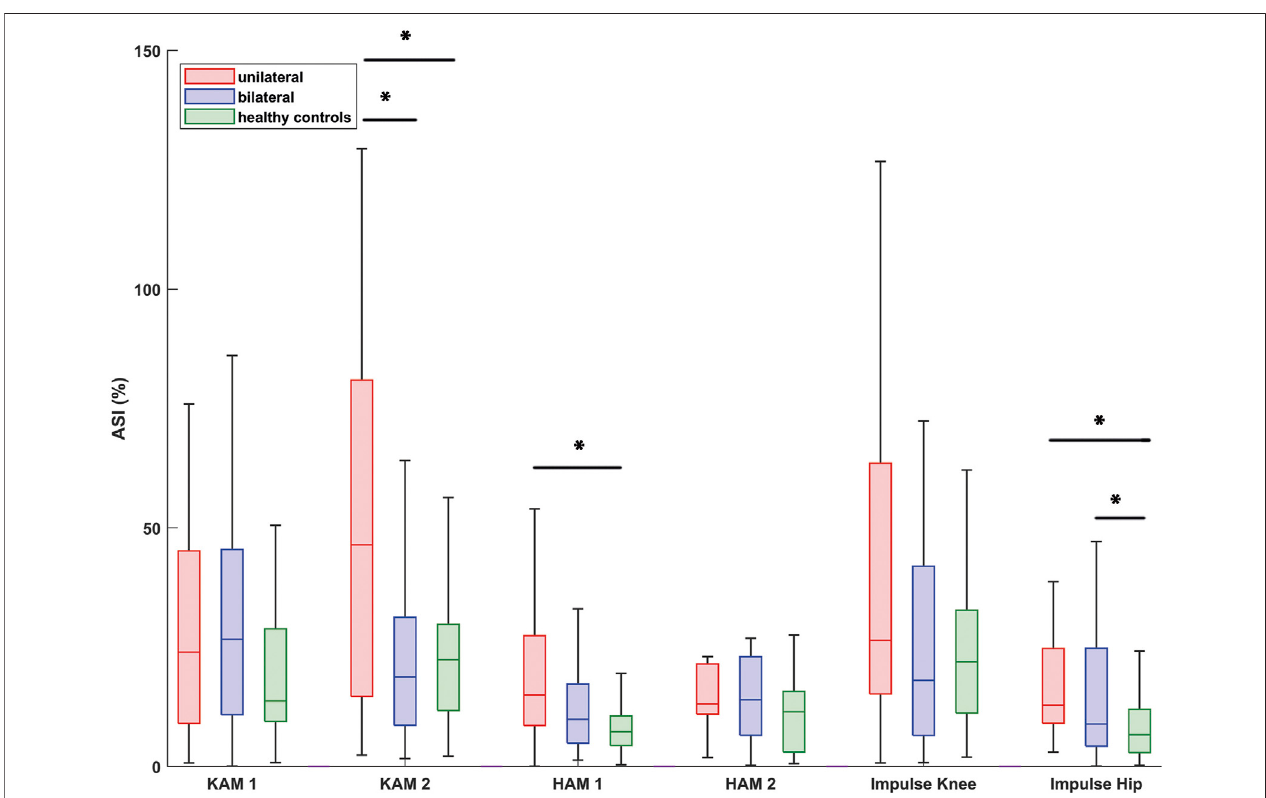
FIGURE 7 | Box-and-whisker-plots of Absolute Symmetry Indices (ASI) of the external knee and hip joint moments as well as the knee and hip impulses. Boxes represent 50% of the data (interquartile range), the line within the box represents the median and each whisker represents 1.5 times the interquartile range. Signi fi cant differencesbetweengroupsareindicatedwithanasterisk.Abbreviations:KAM_1/HAM_1:knee/hipadductionmomentduringthe fi rsthalfofstance;KAM_2/HAM_2: knee / hip adduction moment during the second half of